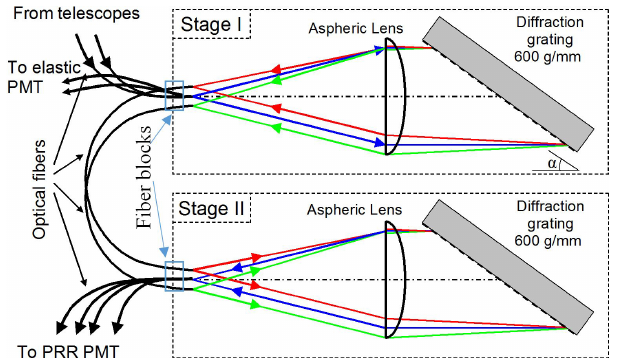
Figure 7. Optics block diagram of PRR polychromator.